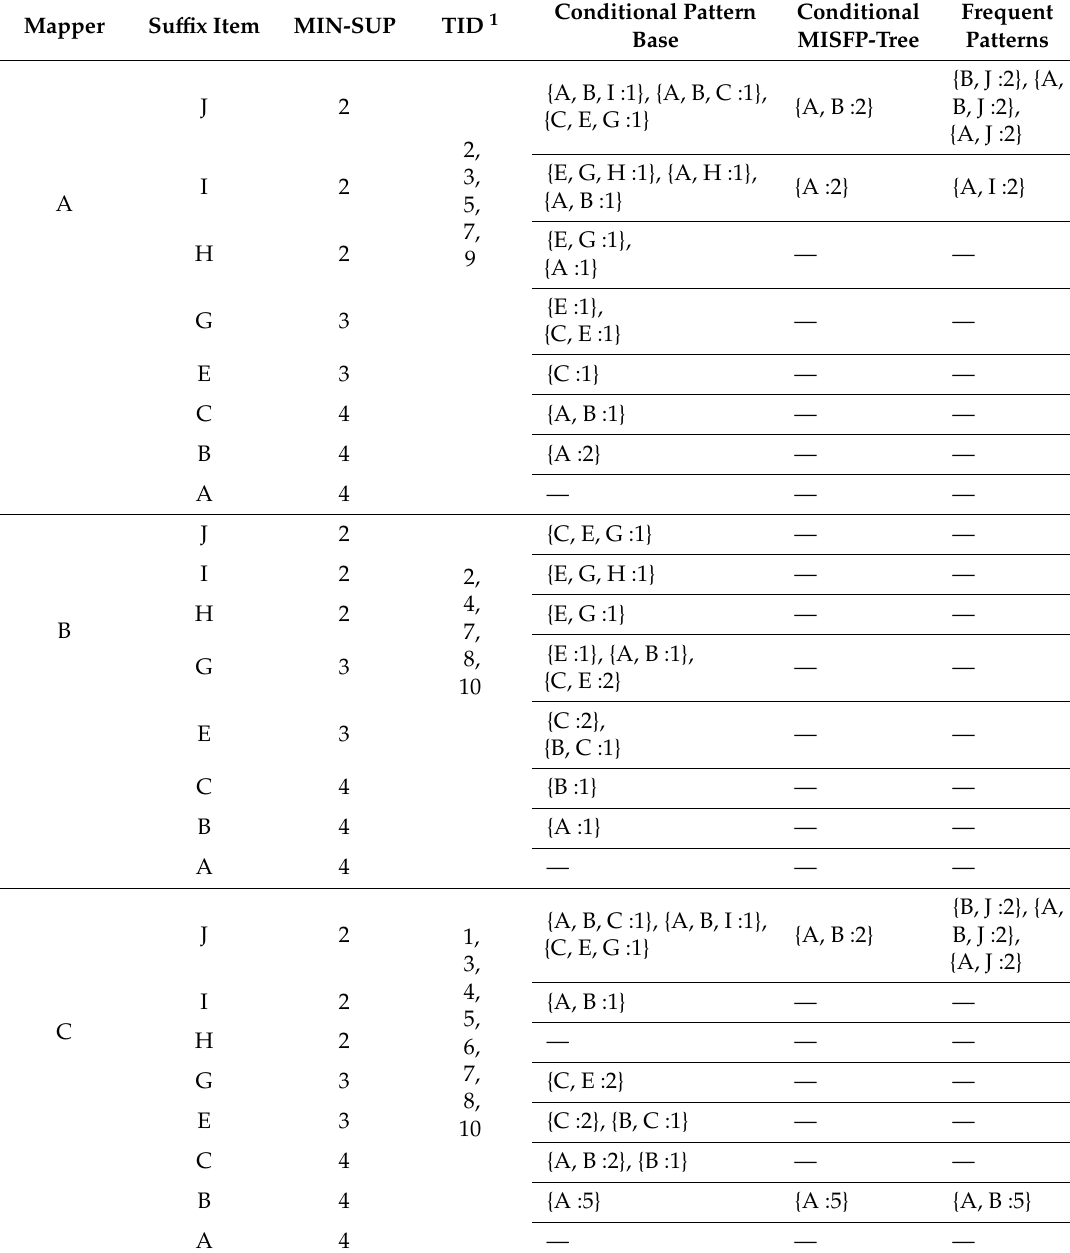
Table 5. The results of frequent patterns.